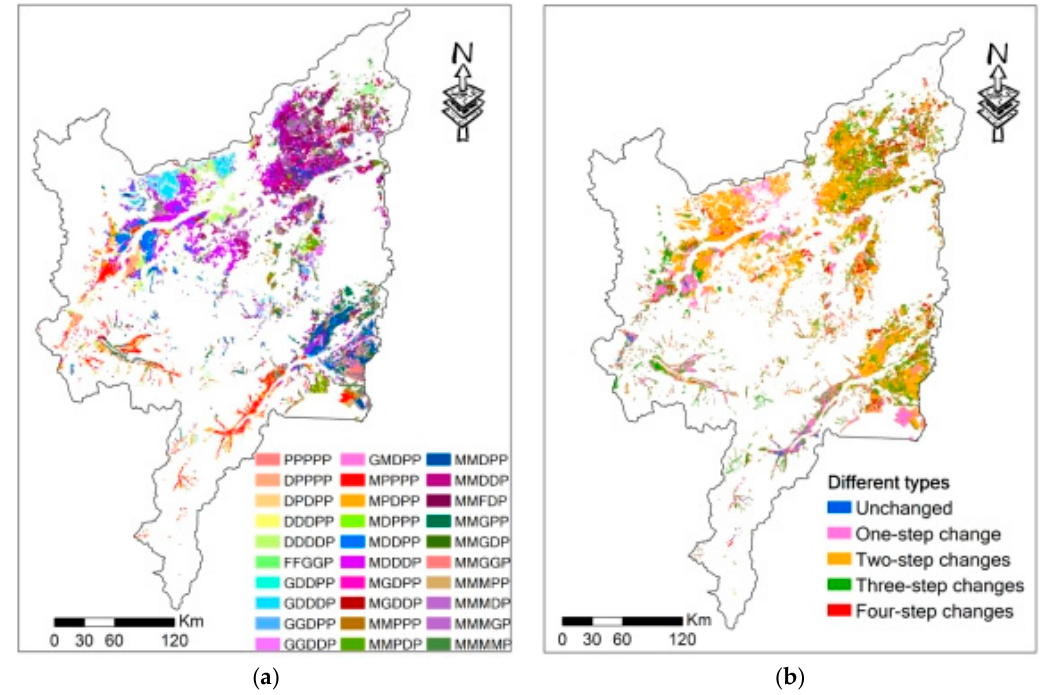
Figure 8. ( a ) Trajectories with different steps and ( b ) main trajectories of paddy field changes. P represents paddy field, D represents dry farmland, F represents forest, G represents grassland, and M represents marsh, respectively.